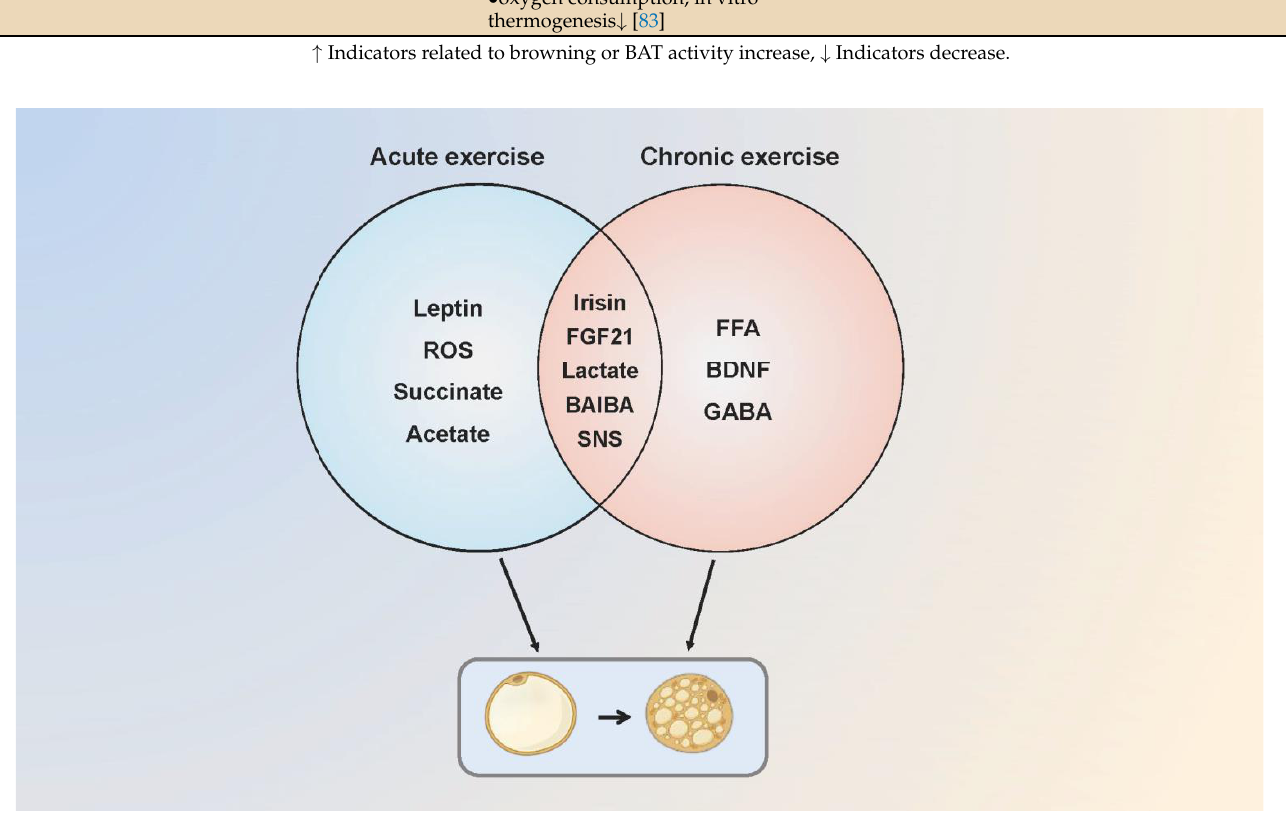
Figure 3. The possible molecular mechanisms of acute and chronic exercise that regulate adipose tissue browning. Acute and chronic exercise regulate the adipose tissue browning through a number of common and distinct molecular mechanisms. Acute exercise mediates browning through irisin, FGF21, leptin, lactate, ROS, succinate, SNS and acetate while chronic exercise possibly mediates through FGF21, SNS, FFA, BAIBA, BDNF, lactate and GABA. Some of the molecular mechanisms are speculative, as browning of adipose tissue has not been measured in the research. SNS, sympathetic nervous system.